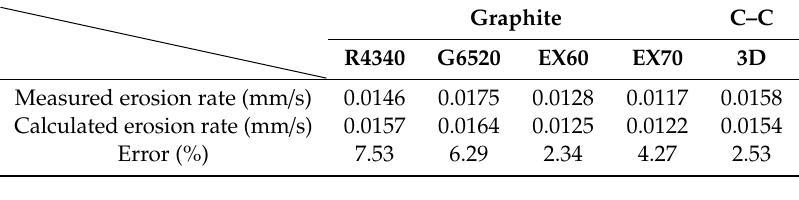
Table 5. The calculated and measured erosion rate of graphite and the C–C composite.